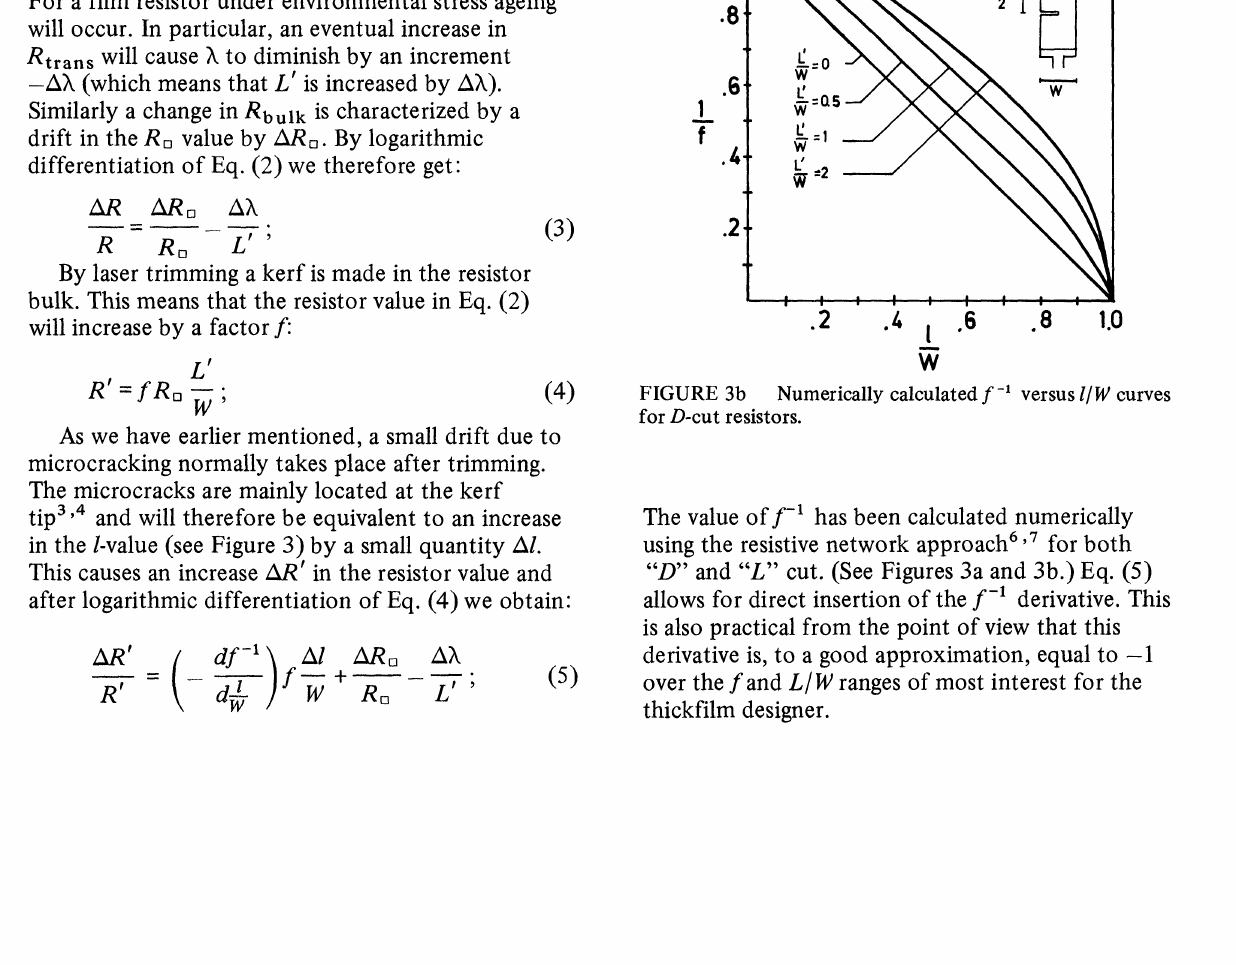
Numerically calculated f-1 versus l/W curves for L-cut resistors.